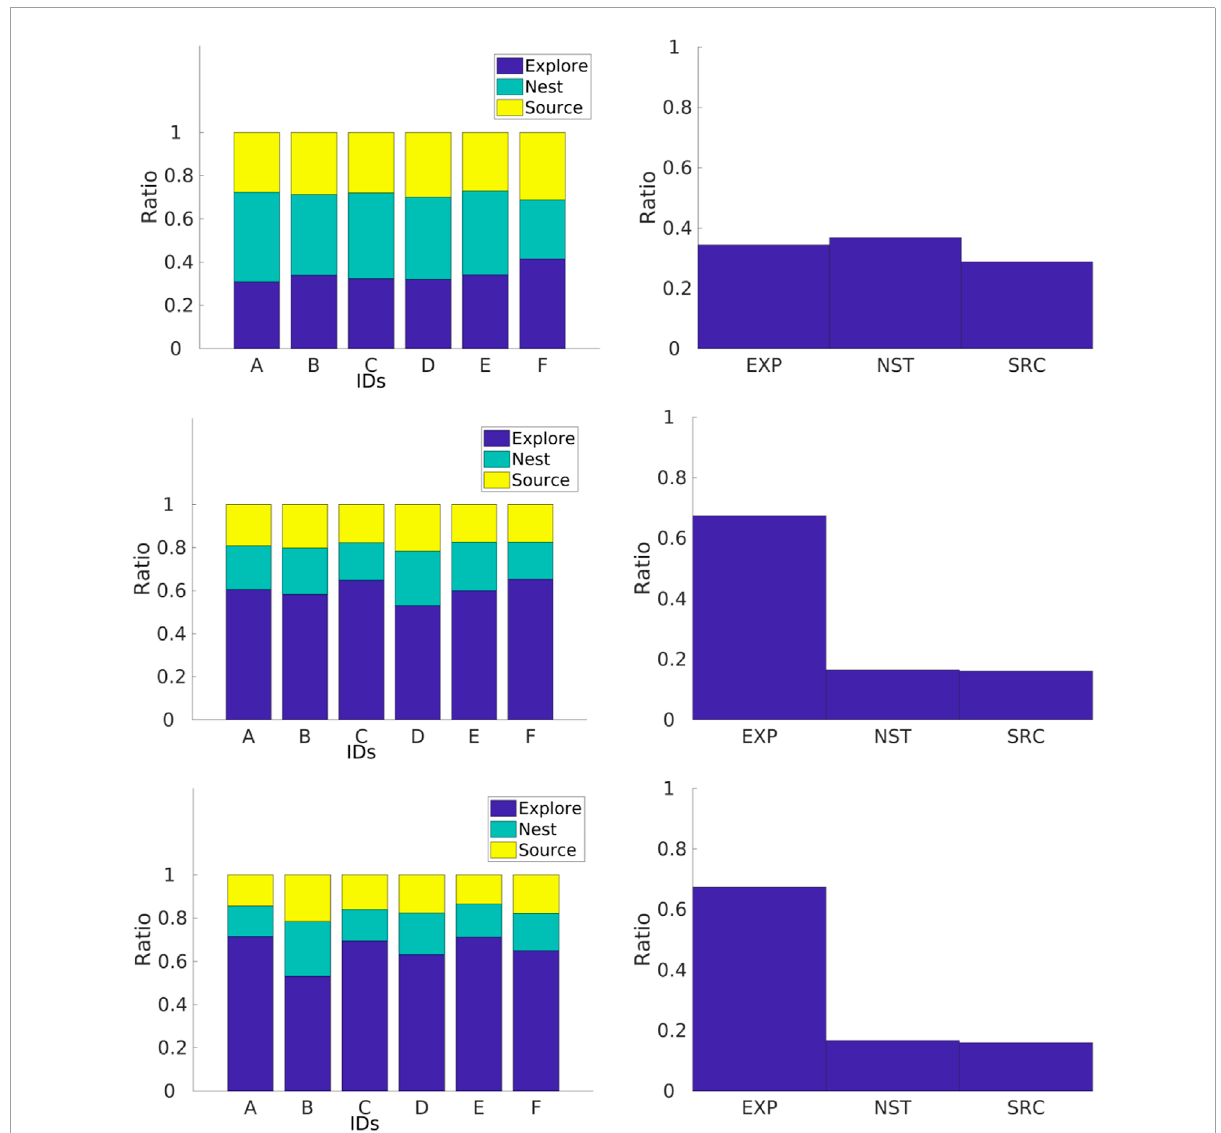
FIGURE 19 Individual performance for physical robots performing the DPS for three different arenas with dimensions of 1.0 m × 1.3 m (a), 2.1 m × 1.2 m (c), and 2.4 m × 1.6 m (e). Time spent in the go-to-source state is roughly similar to that in the go-to-nest state, and time spent in the explore state is lower than that with the